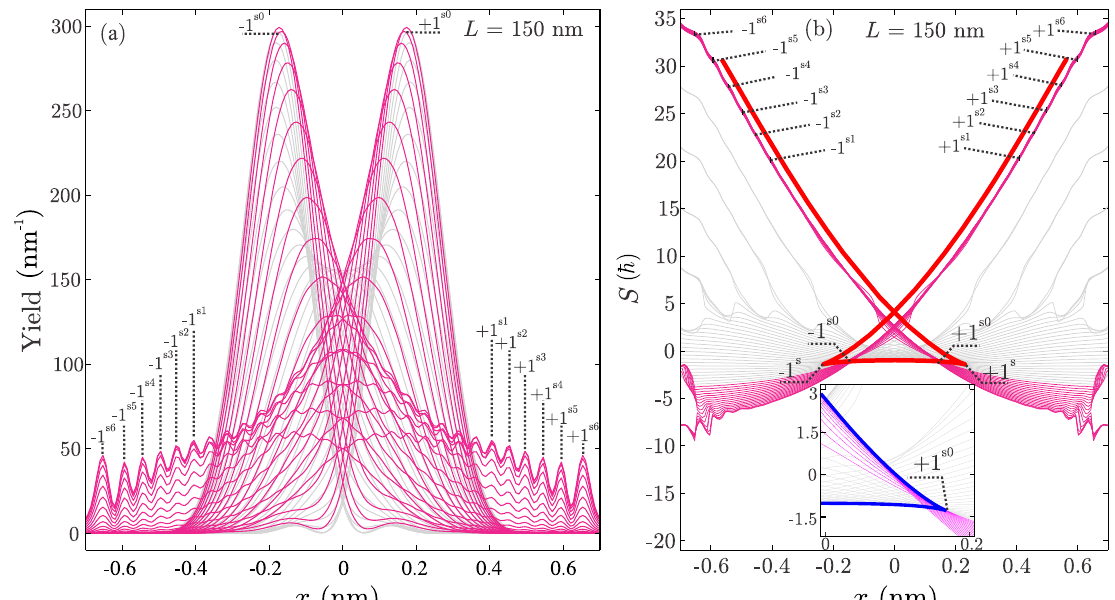
Figure 12. ( a ) The family of wave packet probability densities; ( b ) The corresponding family of wave packet phase functions. The red line shows the classical Hamilton’s principal functions. The blue line shows the envelope function of the quantum phase function family. Inset show enlarged part of the phase function family in the vicinity of the classical singular point + 1 s . The envelope function of the family is shown by the blue line. Members of the rainbow subensemble are designated by magenta lines, remaining wave packets are shown by the gray